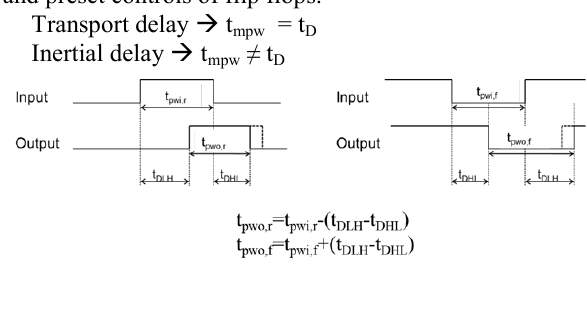
Figure 2. Pulse width filtering characteristic